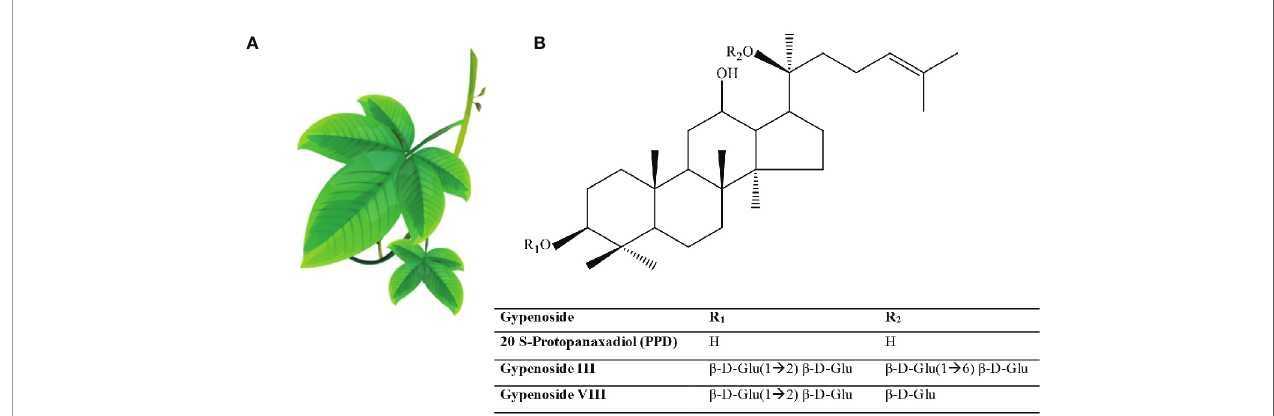
FIGURE 5 | Gynostemma pentaphyllum . (A) Gynostemma pentaphyllum (Source https://pngtree.com/freepng). Examples of the chemical structure of Gynostemma pentaphyllum Gypenoside that are usually synthesized 20 S-Protopanaxadiol (PPD). (B) example of some chemical structures of